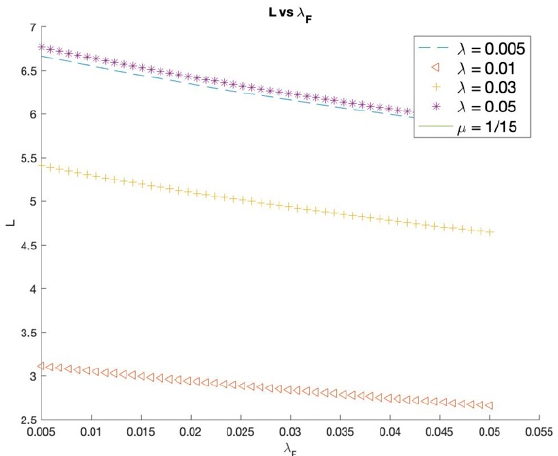
Figure 11. Average number of customers in system ( L ) vs rate of unsuccessful arrival ( λ F ). The following graph plots (cid:1838) (cid:3018) versus λ (cid:3007) , for various λ , a (cid:2020) (at 1/15), and (cid:1866) (at 10) in Figure 12.